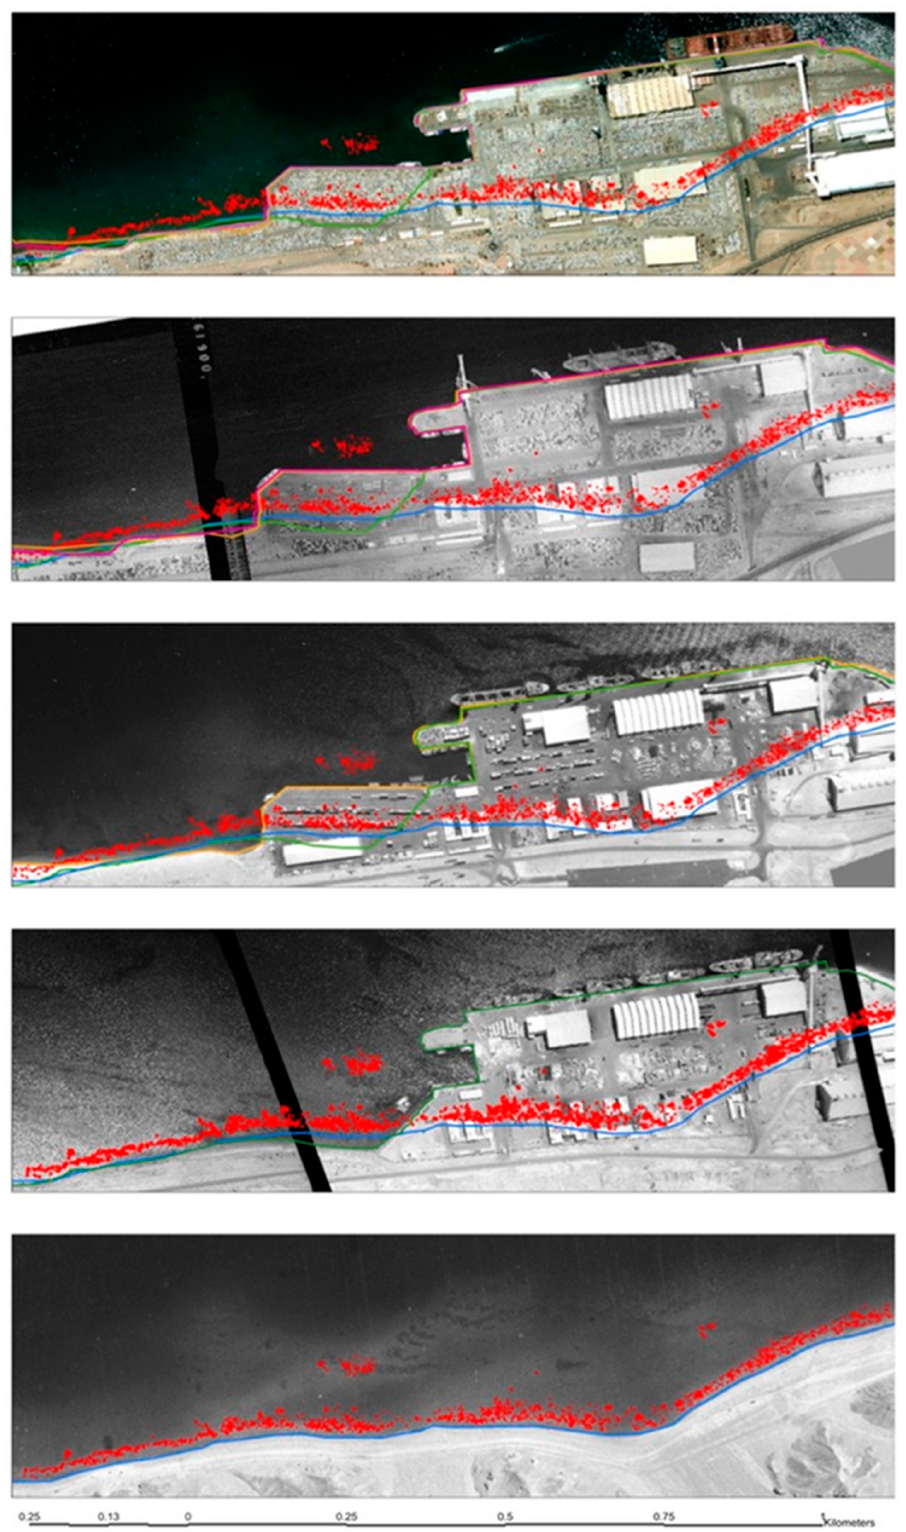
Figure 4. Historical aerial images over the area of Eilat Commercial Port (region 4 in Figure 1) between the years 1957 and 2015. Red contour delineates the border of the reef as identified in the 1957 image. Blue, Green, Brown, Purple contours delineate the shoreline as identified in the 1957, 1969, 1977, 1995, and 2015 images, respectively.